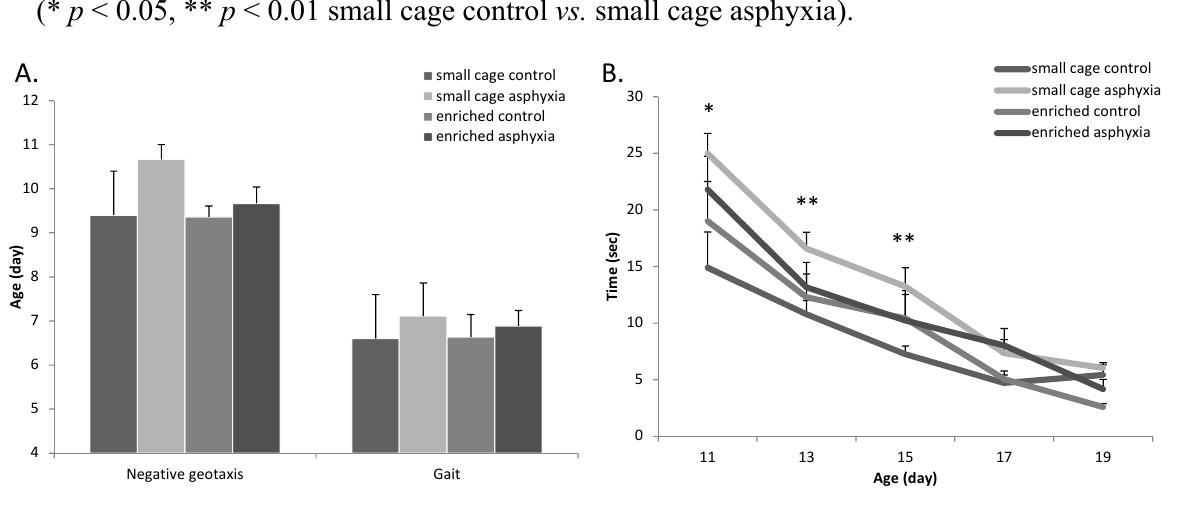
Figure 3. ( A ) Negative geotaxis and gait appearance; ( B ) Gait test performance (* p < 0.05, ** p < 0.01 small cage control vs. small cage